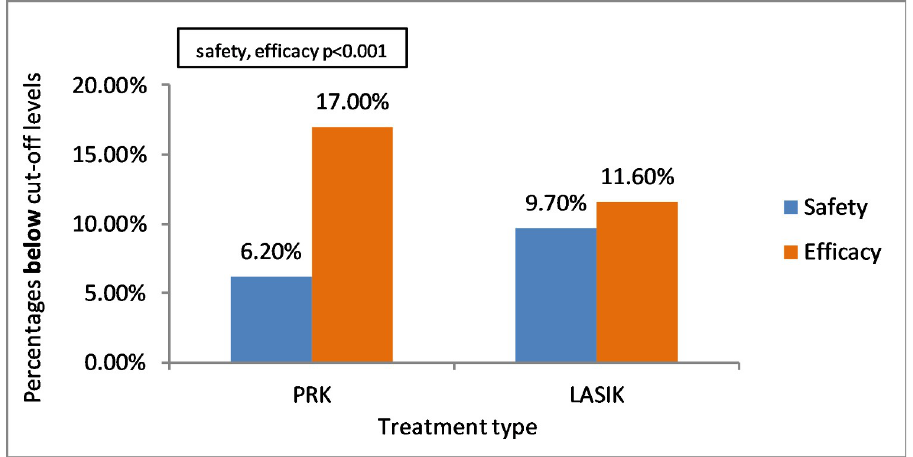
Fig 2. Association between treatment type and eyes below safety and efficacy cut-off levels using univariate analysis and Pearson Chi-Square test (p < 0.001 for both safety and efficacy). PRK = photorefractive keratectomy; LASIK = laser assisted in situ